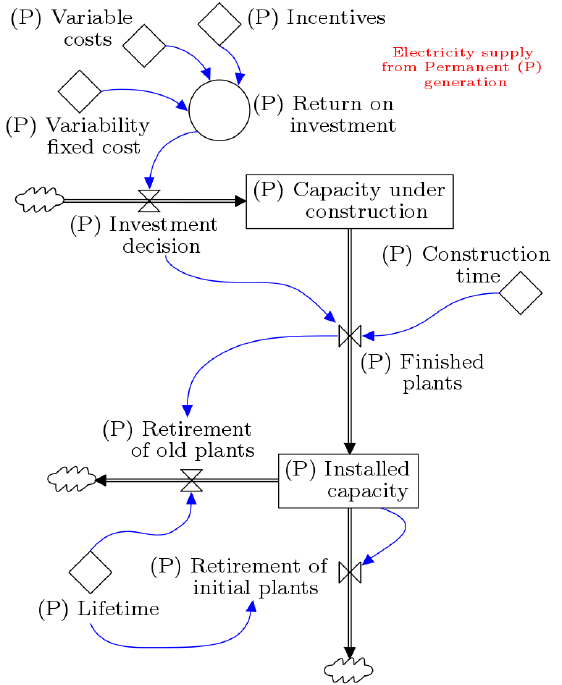
Figure 2. Electricity supply from ( P )